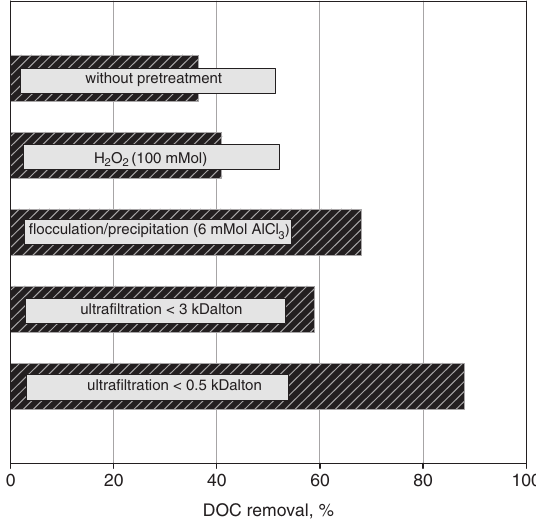
Fig. 5. The degradability of DOC of different pre-treated water from a depth of 24 m of the wastewater disposal pond in a methanogenic enrichment